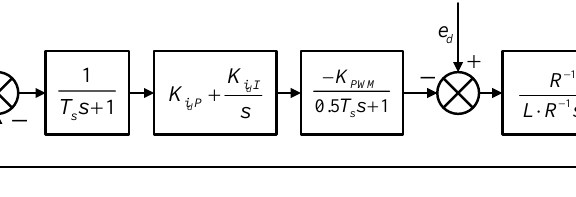
Figure 8. Transfer function of BESS.